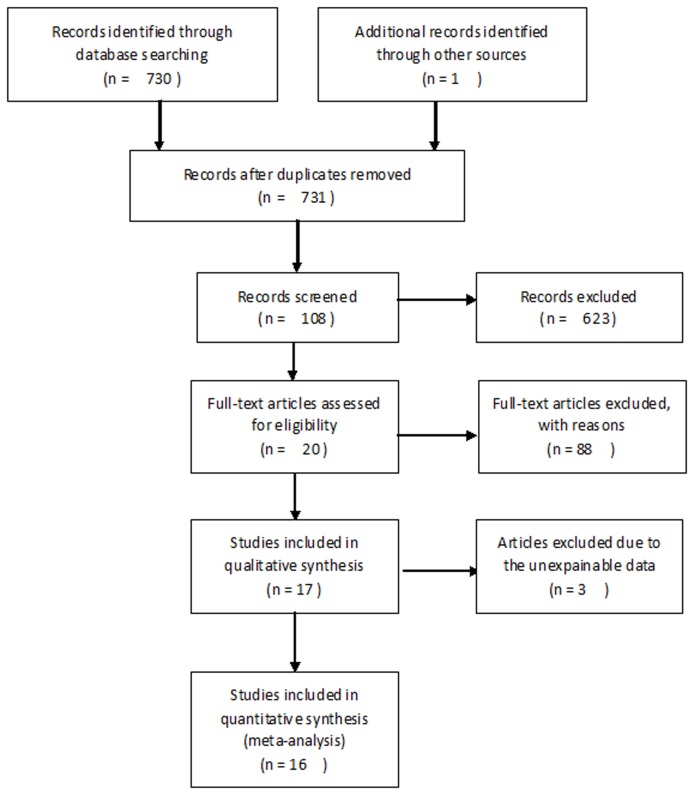
Flow diagram of study selection.